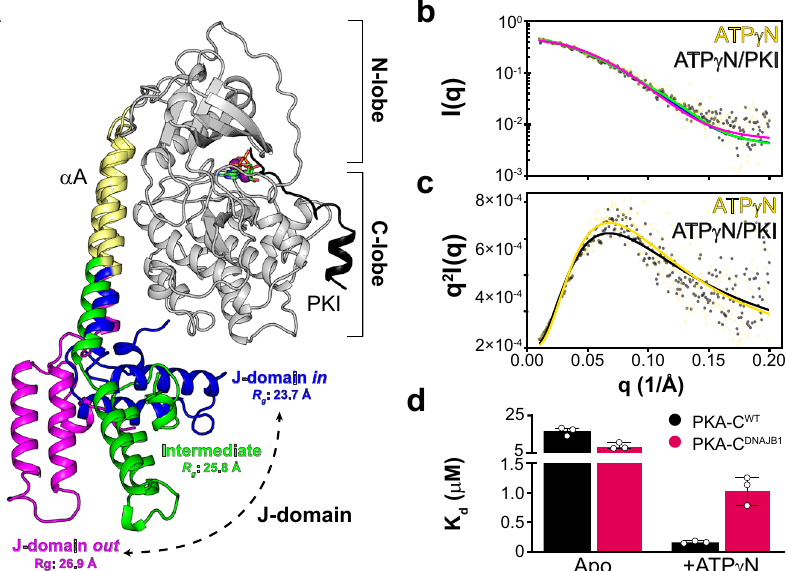
Fig. 1 Multiple conformations adopted by the dynamic J-domain alters allosteric binding cooperativity of PKA-C. a Overlay of selected snapshots of PKA-C DNAJB1 from the MD trajectories highlighting the ensemble of conformers sampled by the J-domain. b SAXS pro fi les of PKA-C DNAJB1 . Continuous lines show the structural fi tting of the experimental SAXS data with the closed (J-domain in , blue), intermediate (green), and extended (J-domain out , magenta) conformations for binary (ATP γ N-bound) and ternary (ATP γ N/PKI-bound) forms. The conformations are extracted from the MD trajectories. c Corresponding Kratky plot of PKA-C DNAJB1 bound to ATP γ N and ATP γ N/PKI. d Bar graph showing the dissociation constants ( K d ) calculated from the ITC titration curves of PKI 5 – 24 binding to the apo and ATP γ N-bound forms of PKA-C WT and PKA-C DNAJB1 (see also Supplementary Table